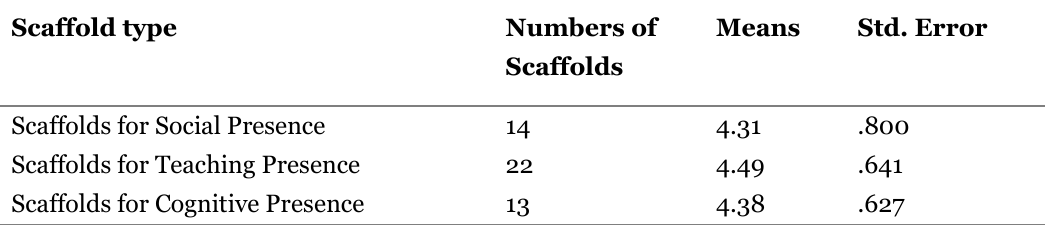
Scaffold type Numbers of